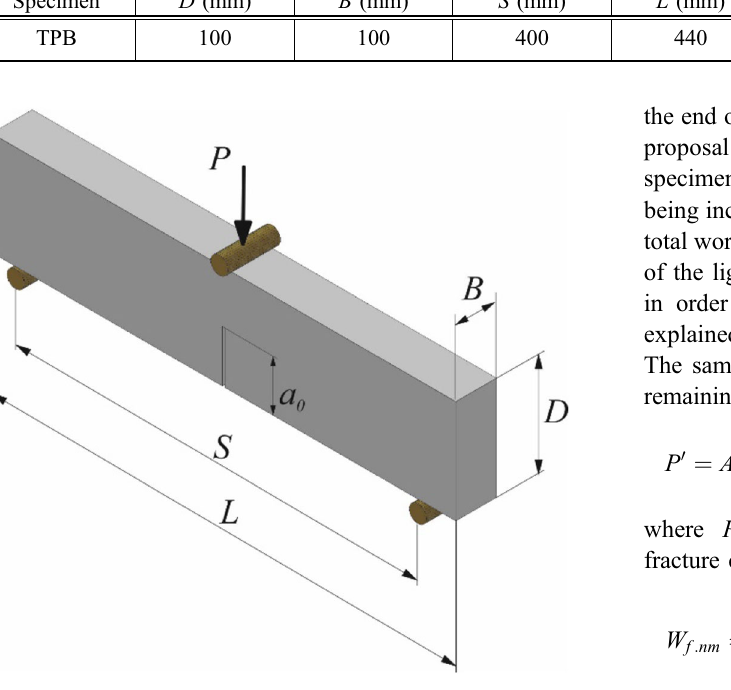
Fig. 8 Geometrical shape parameters of notched specimens used in the TPB tests.